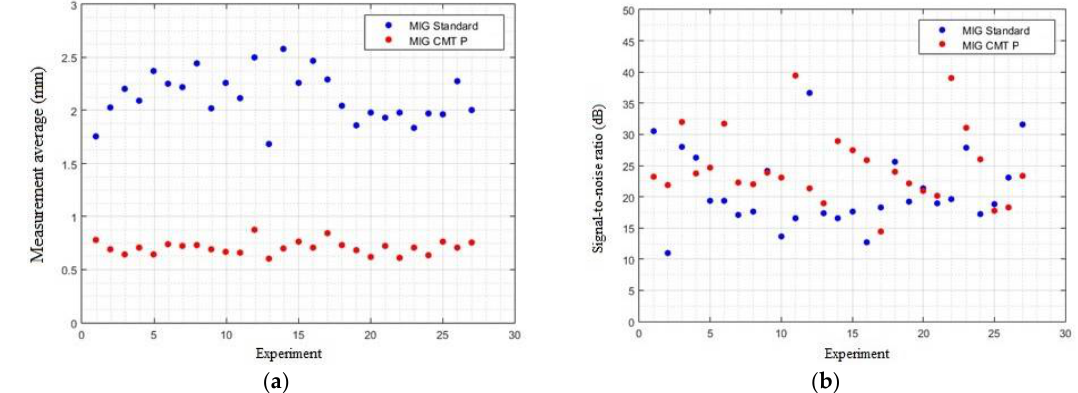
Figure 4. Penetration evaluation: ( a ) measurement (mm); ( b ) signal-to-noise ratio (dB).